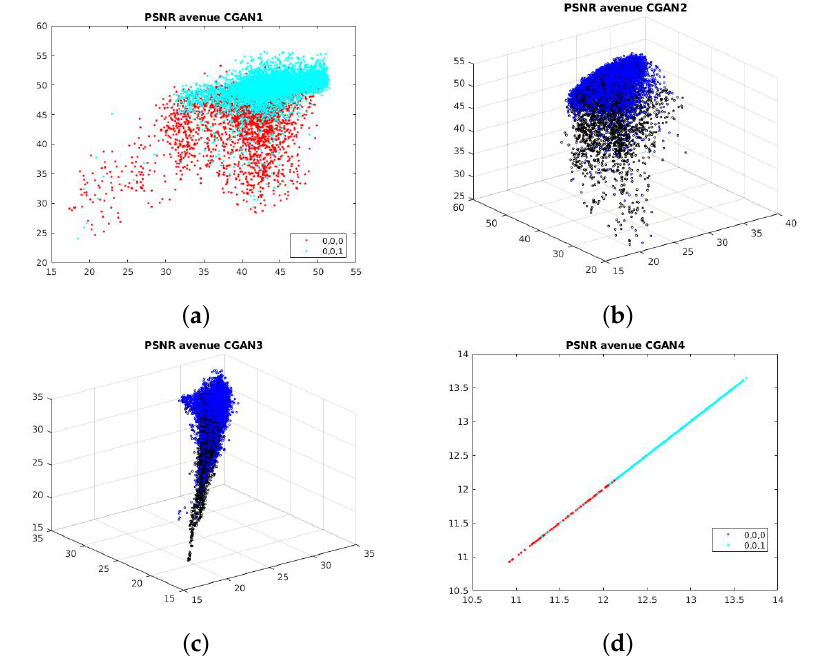
Figure 7. Distribution of normal and abnormal samples in Avenue dataset. For CGAN-2 ( b ) and CGAN-3 ( c ), normal points are blue and abnormal points are black. For CGAN-1 ( a ) and CGAN4 ( d ), normal = light blue and abnormal = red. Obviously, normal samples situate in higher values than abnormal ones. This distribution corresponds to the fact that PSNR techniques produce high scores if predicted images tend to similar source images. On one side, because Avenue contains RGB images, CGAN-3 has 3-dimensions